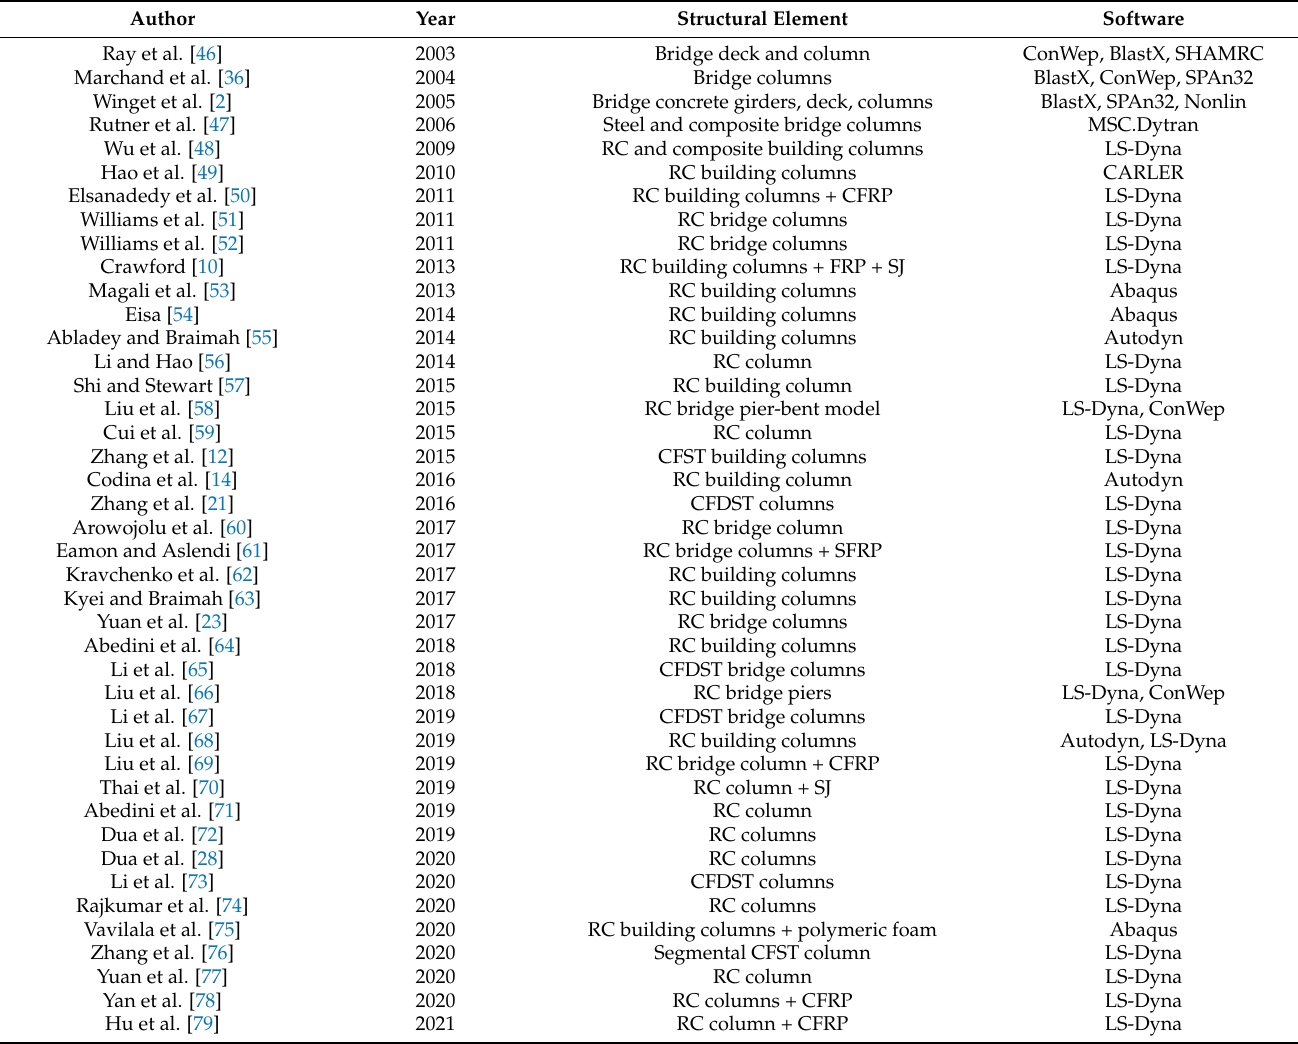
Table 4. Summary of software for prediction and calculation of blast